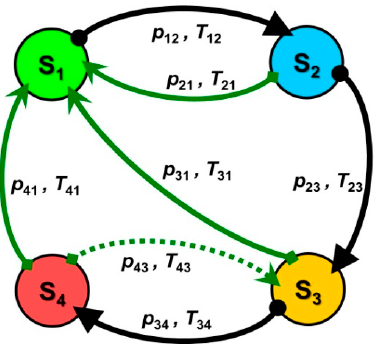
∈ S ( i = 1, 2, 3, 4 ) of the process { W ( t ) : t ≥ 0 } [4]. i